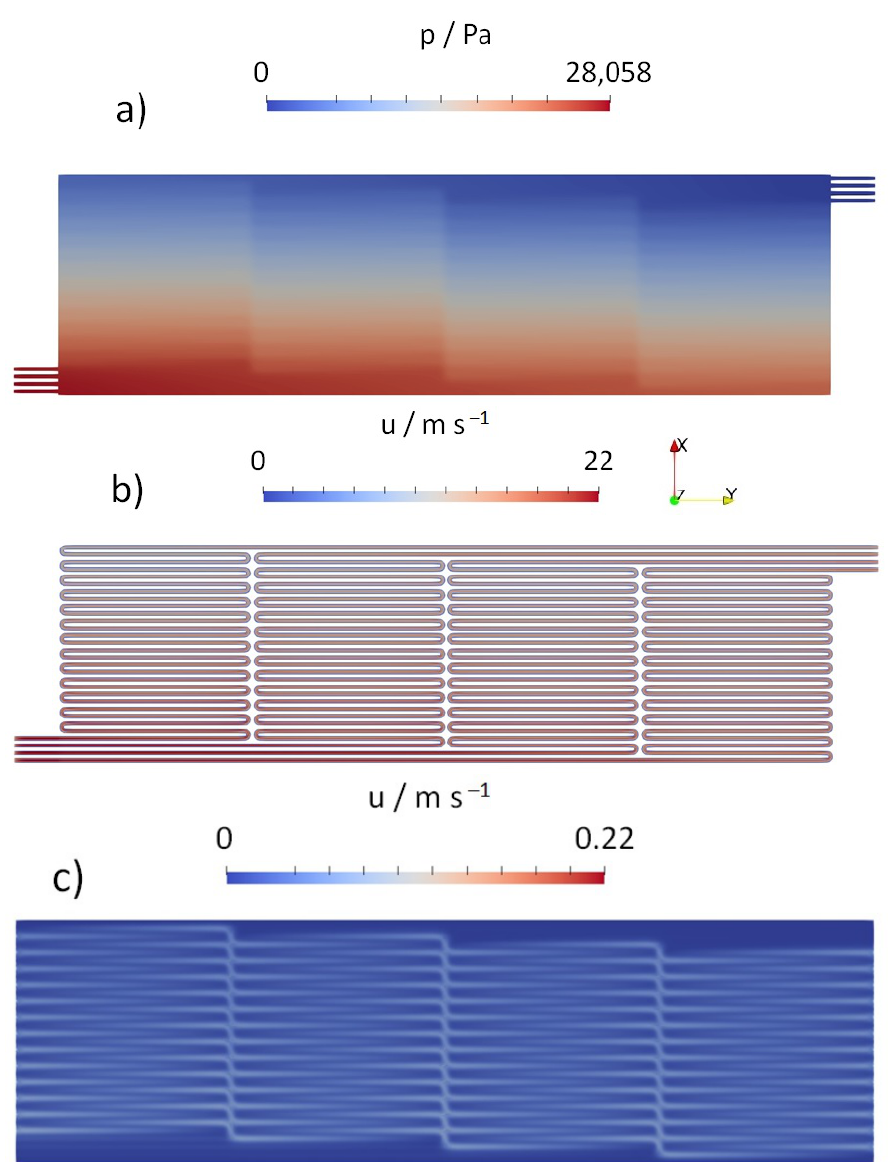
Figure 13. Flow distribution for the anode plate at 0.44Acm − 2 . ( a ) Pressure distribution; ( b ) velocity (magnitude) at half channel depth; ( c ) velocity (magnitude) at half GDL